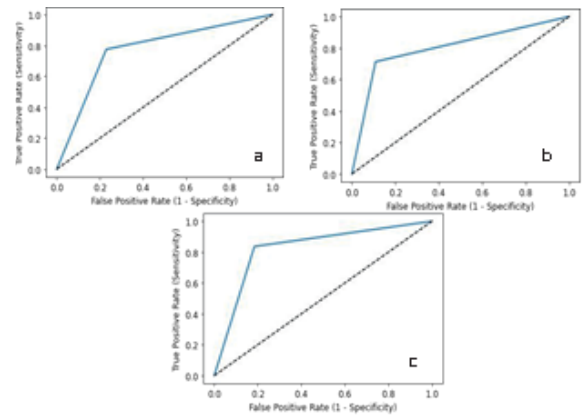
Figure. 6. ROC Curve (a. SVM; b. RF; c. XGBoost)